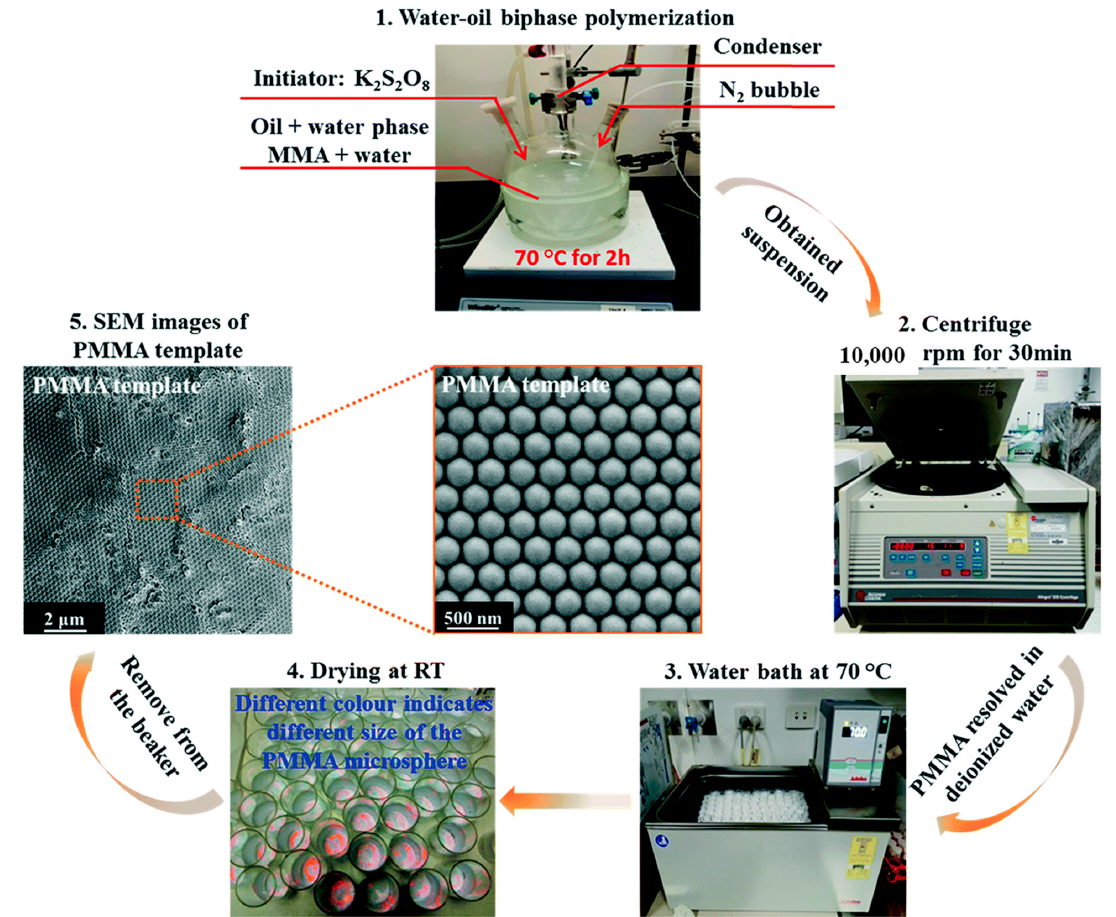
Figure 1. Equipment and process used to synthesize the PMMA microspheres template. Reprinted with permission from Ref. [35] . Copyright 2018, copyright Royal Society of Chemistry.